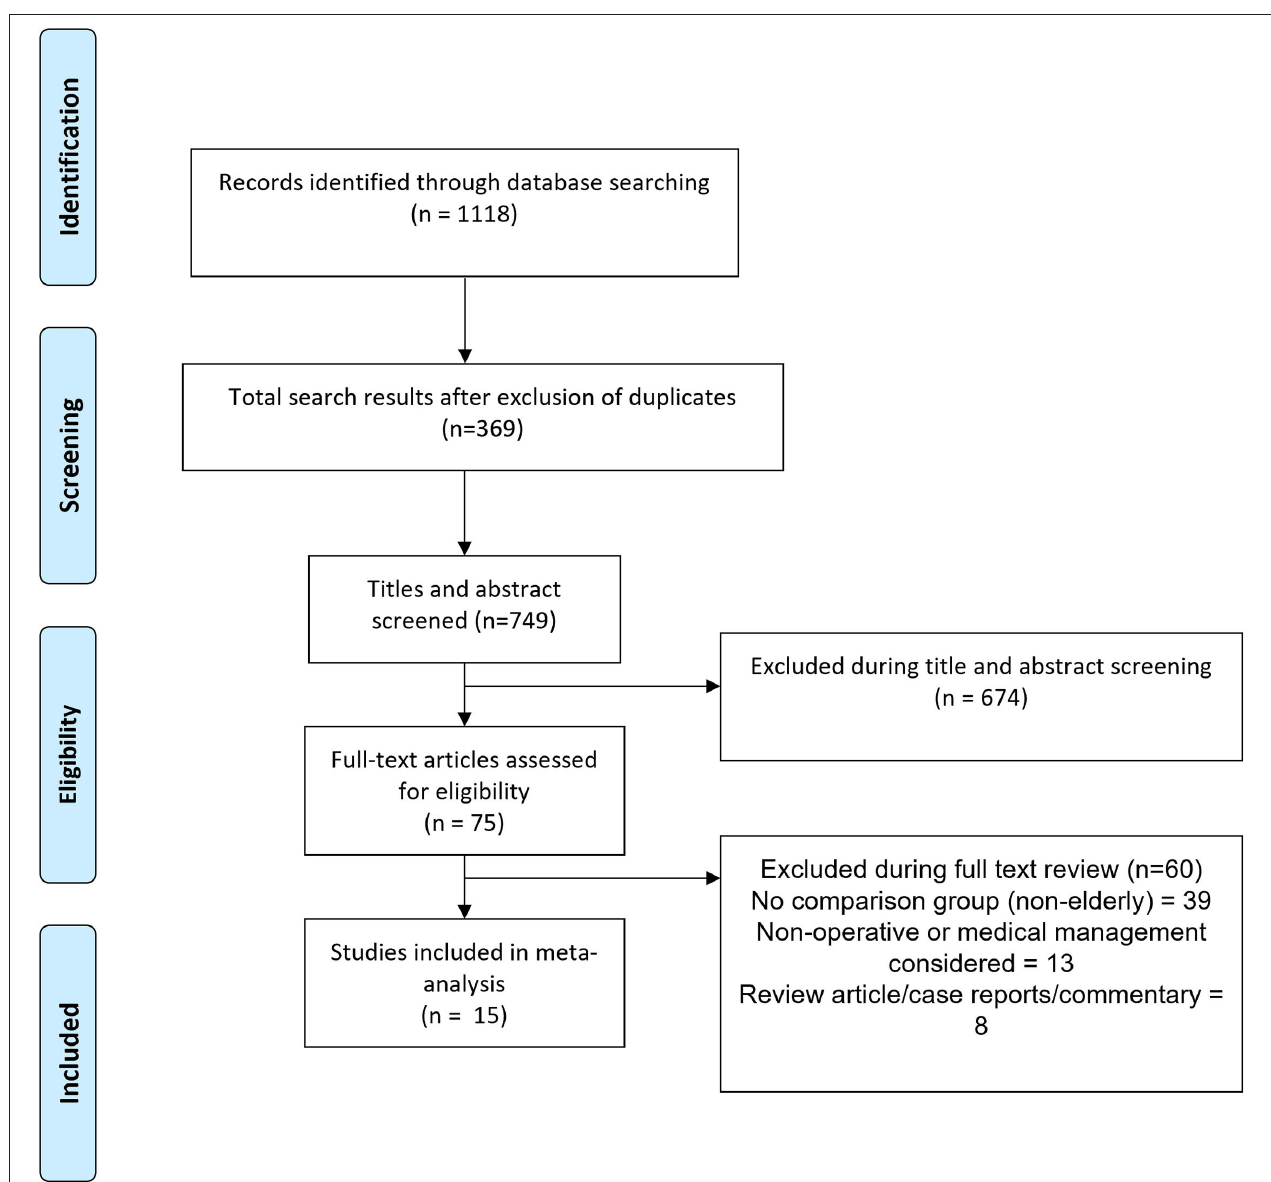
FIGURE 1 | The selection process of the studies included in the review.